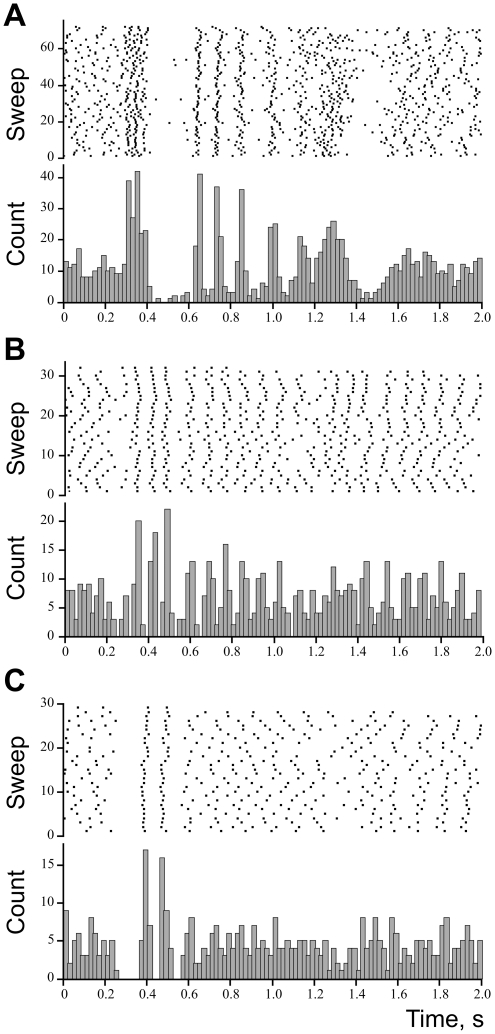
Phase-locking and resetting of ongoing muscle spindle discharge.For further details see text and legend of Fig. 2.